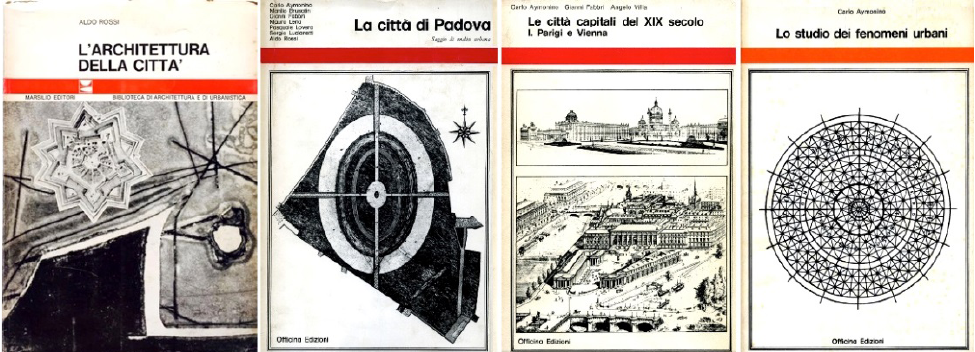
Figure 8. Publications dedicated to the theme of the city and urban architecture. From left to right: Aldo Rossi , L’architettura della Città ( The Architecture of the City ), 1966; Carlo Aymonino, La Città di Padova ( The City of Padua ), 1971; Carlo Aymonino, Le Città Capitali del XIX Secolo ( The Capital Cities of the Nineteenth Century ), 1975; Carlo Aymonino, Lo Studio dei Fenomeni Urbani ( The Study of Urban Phenomena ), 1977.